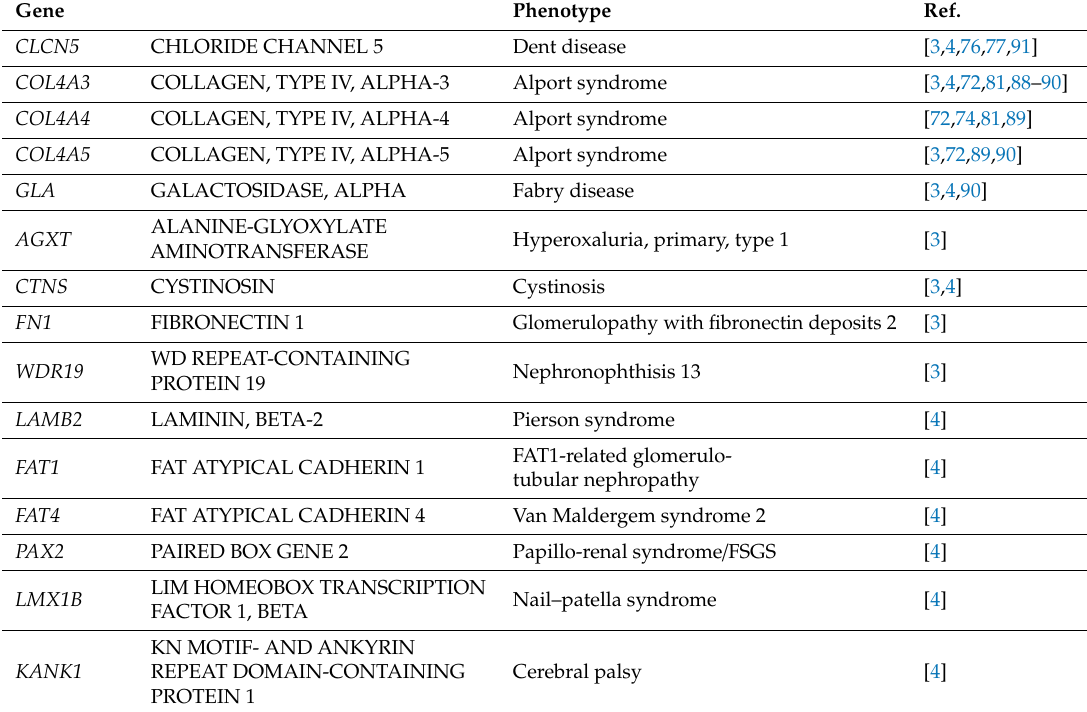
Table 2. Phenocopy genes. This is a table illustrating phenocopy genes and the disease usually caused by their mutations